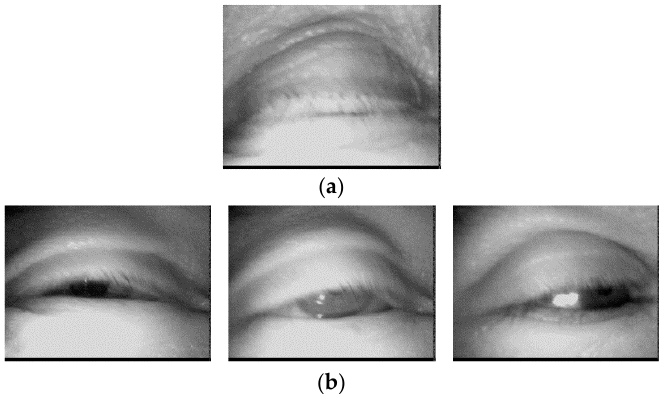
Figure 13. Error images from the classification of open and closed eye images of open database of NIR eye images using the proposed method. ( a ) Type 1 error; ( b ) type 2 error.